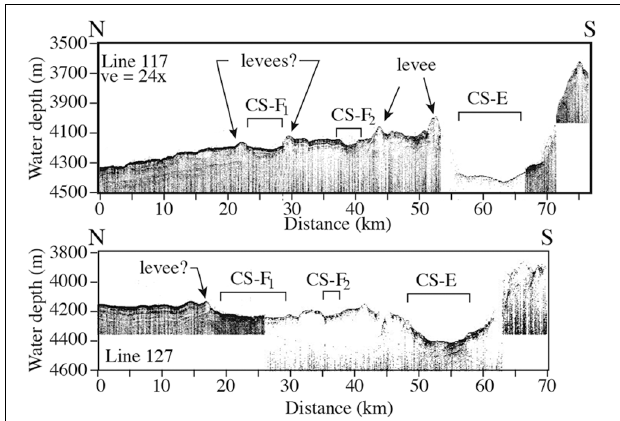
FIGURE 13 | Two subbottom seismic profiles that cross CS-E and CS-F1 and CS-F2. Note the levee on CS-E and probable levees on CS-F1 and CS_F2. See Figure 12 for locations. Also, note the relief of CS-E below level of the abyssal basin